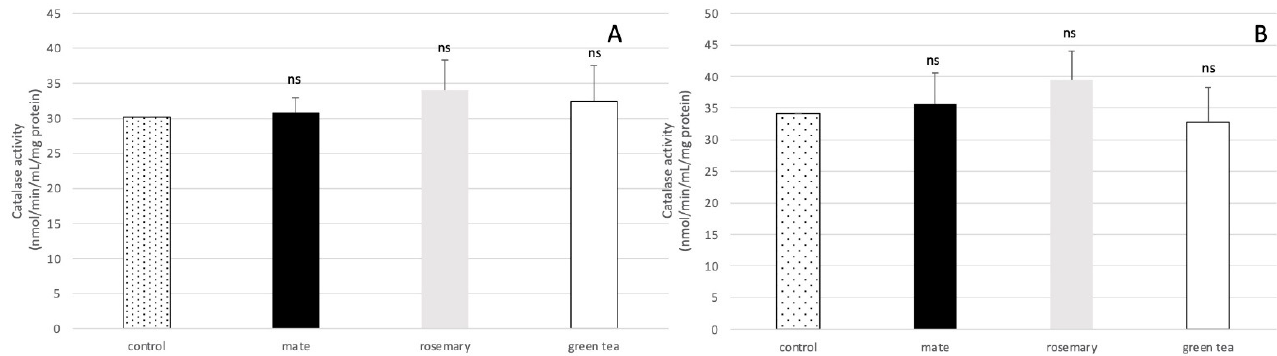
8 of 16 Figure 6. AFB1 production when exposed to low concentrations of mate (black bars) and green tea (white bars). Results correspond to the mean +/ − SD of three distinct experiments and are expressed as percentages of the AFB1 produced by untreated A. flavus control cultures. Significant differences between concentrations of the same plant extract are indicated by * for p -value< 0.05, and by *** for p -value < 0.001. ns: not significant.